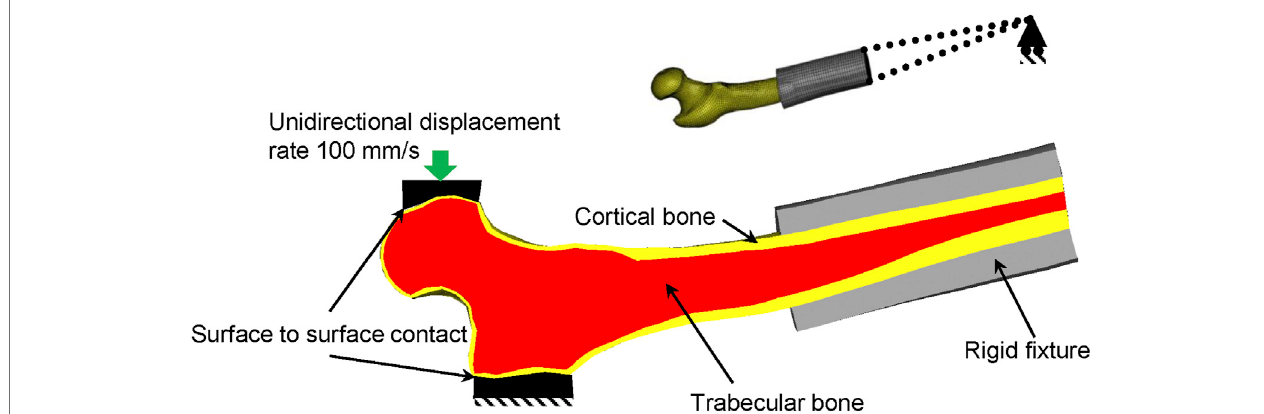
FIGURE2| Theproximalsectionofthefemurwaspositionedinthesidewaysfallcon fi guration.Therigid fi xturewasconnectedtoexternalnodesofthedistalfemur that could rotate in the sagittal plane. The displacement was applied to the femoral head.